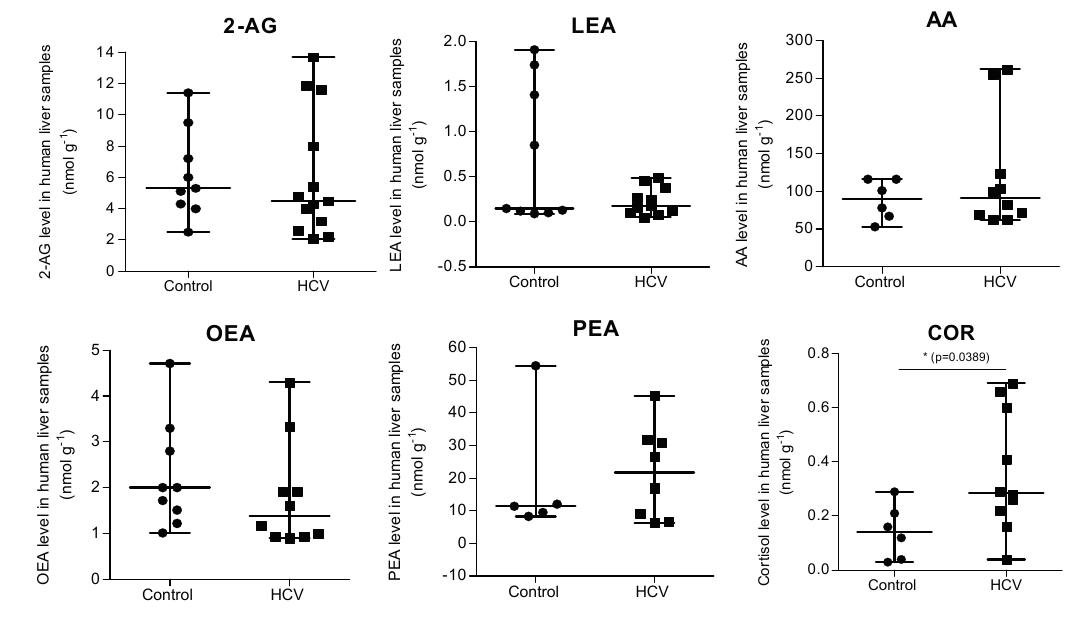
Figure 1. Endocannabinoid (ECs) and related fatty acid amides expression in hepatitis C. ( A ) Levels of ECs in plasma from patients with chronic hepatitis C (CHC) ( n = 57) and healthy controls ( n = 25); ( B ) levels of ECs, fatty acids amides and cortisol in control ( n = 9) and hepatitis C virus (HCV)-infected ( n = 17) liver tissues. * p = 0.0389 vs. control.